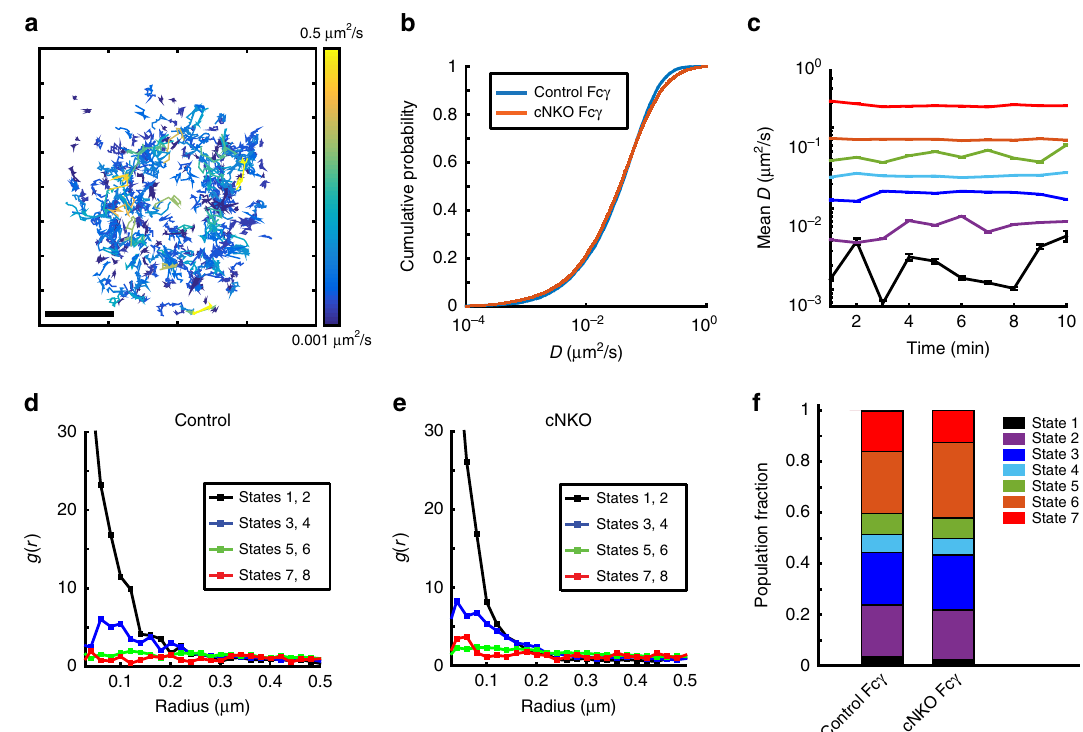
Fig. 6 Fc γ RIIB mobility is mildly affected by the lack of N-WASP. a A set of single-molecule tracks of Fc γ RIIB from an activated B cell over a 10-min period. Scale bar is 1 μ m. b Cumulative distribution plots for diffusivity of Fc γ RIIB molecules in control and cNKO cells (control cells N = 12, cNKO cells N = 12). c pEM analysis of single Fc γ RIIB molecule trajectories uncovered seven states. Plot shows the mean diffusivity of each state at every time point. Error bars represent the standard error of the mean. The colors corresponding to the different states are as shown in f . d , e Pair correlation function plot for all states in control and cNKO states respectively. f Comparison of the population fraction of different diffusive states of Fc γ RIIB in control and cNKO cells. Source data are provided as a Source Data fi